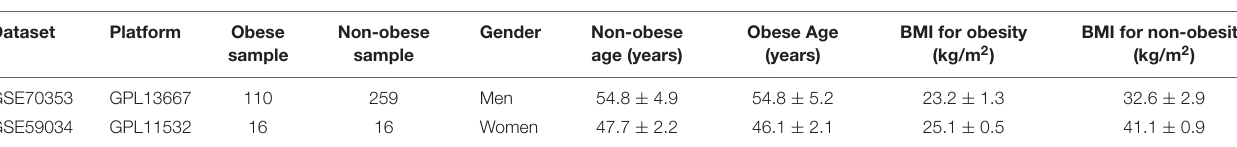
FIGURE 1 | The flow chart of this study. DEGs, differentially expressed genes; GSEA, Gene set enrichment analysis; GO, Gene ontology; KEGG, Kyoto Encyclopedia of Genes and Genomes; MCC, maximal clique centrality. TABLE 1 | Details for GEO obesity adipose tissue